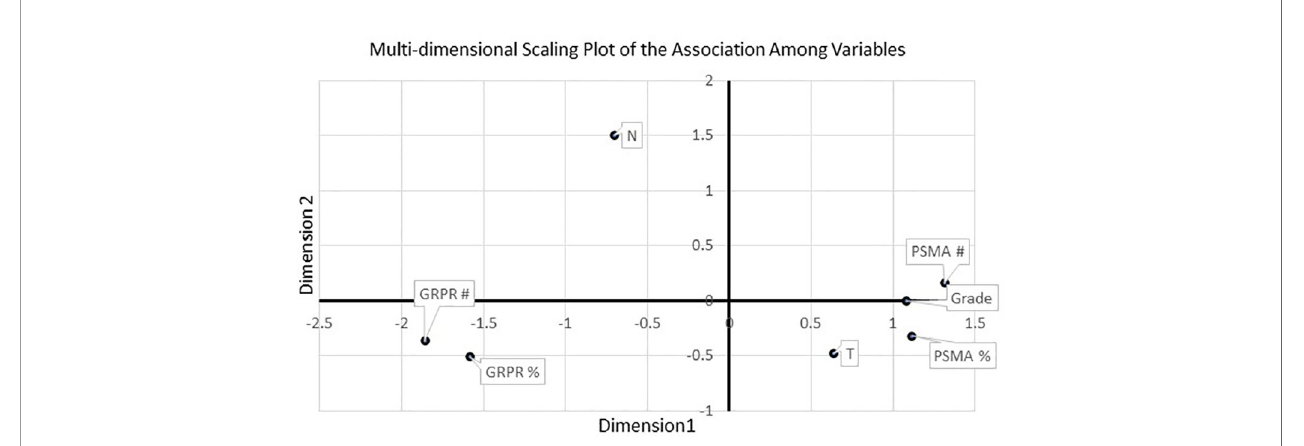
FIGURE 4 | MDS revealed a signi fi cant inverse relationship between GRPR markers and tumor grade, as well as a positive association with PSMA markers. T stage was also related to